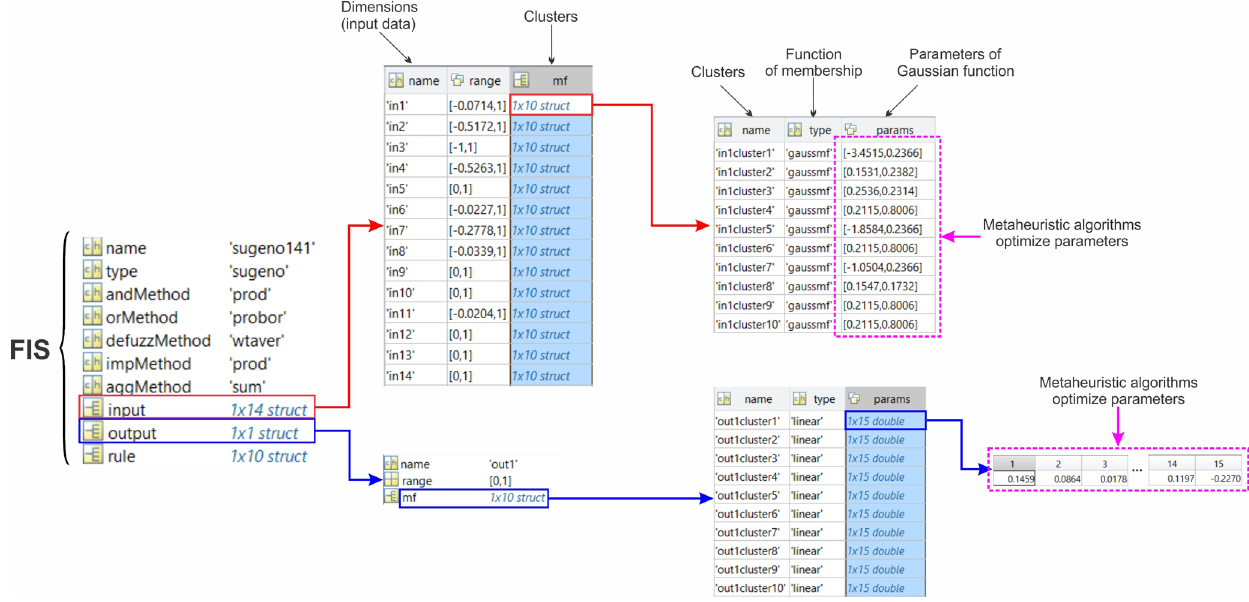
Figure 4. General methodological flow of ANFIS.